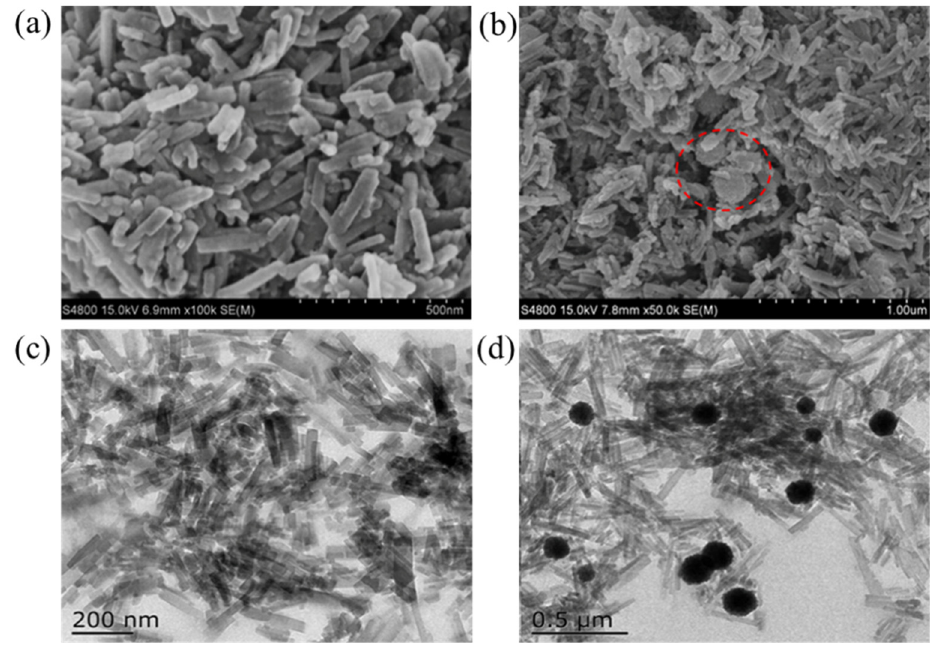
Figure 2. SEM images of ( a ) MIL-53(Al), ( b ) Fe 3 O 4 @MIL-53(Al); TEM images of ( c ) MIL-53(Al) and ( d ) Fe 3 O 4 @MIL-53(Al).